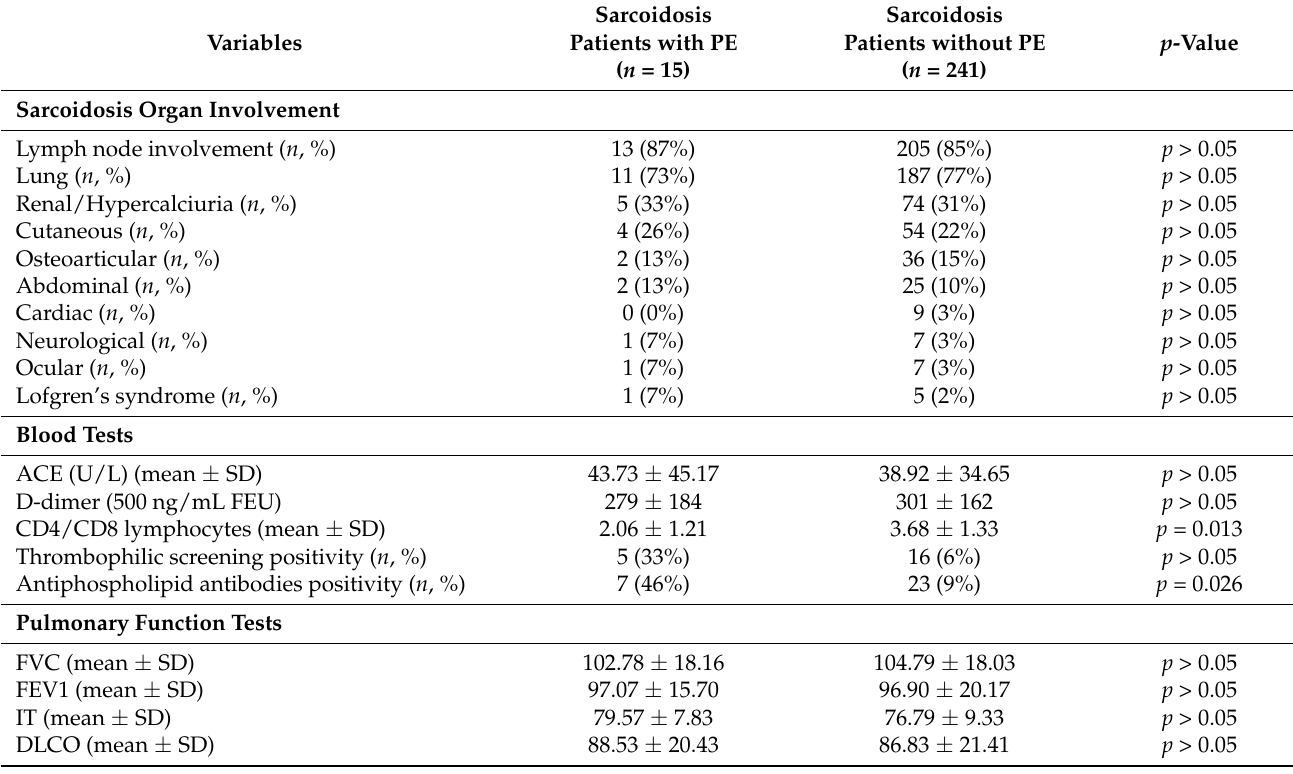
Legend. n = number of patients, % = percentage of patients; ACE = angiotensin converting enzyme, FEU = Fibrinogen Equivalent Units, FVC = functional vital capacity, FEV1 = forced expiratory volume in 1 s, IT = Tiffenau index = forced expiratory volume in 1 s/functional vital capacity, DLCO = diffusion capacity of carbon